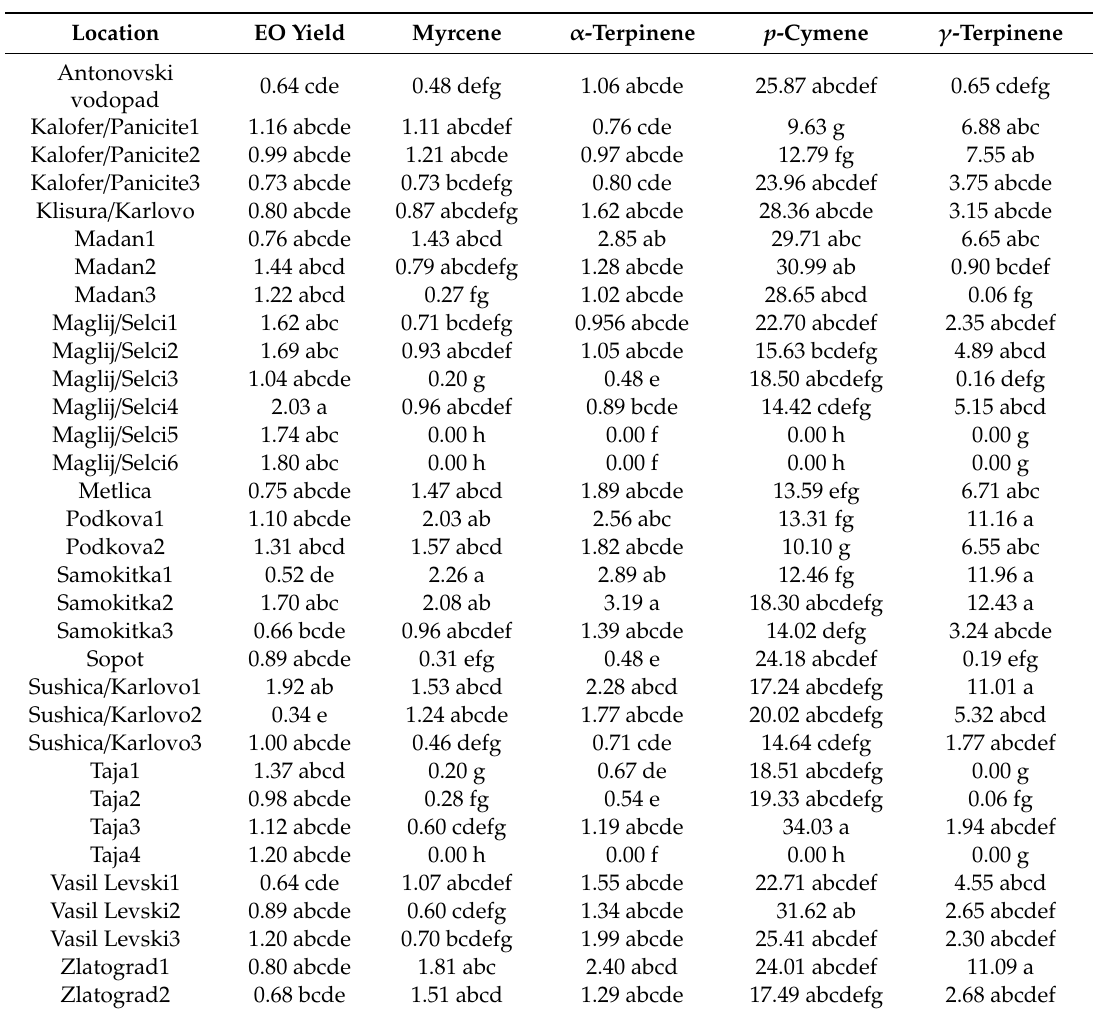
Table 1. Mean EO yield (%) and the percent compositions (%) of myrcene, α -terpinene, p-cymene, and γ -terpinene (major Satureja pilosa constituents) collected at 33